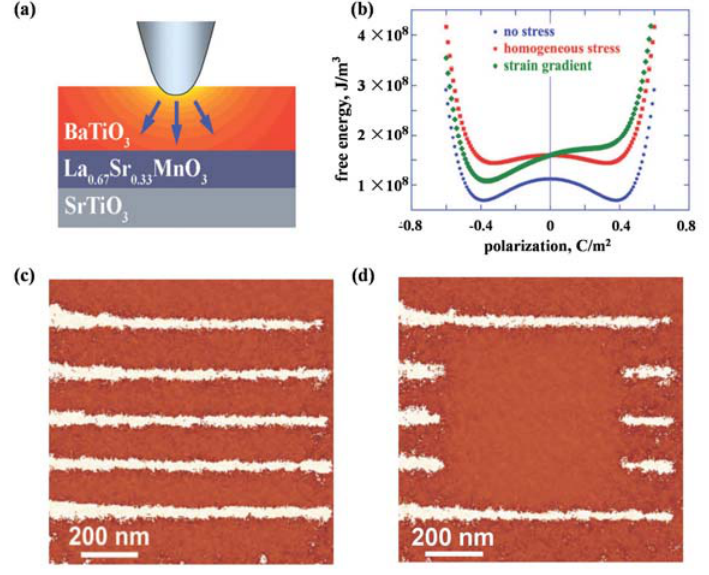
Figure 10. ( a ) Sketch of the strain gradient and associated flexoelectric field (arrows) induced by the AFM tip pushing on the surface of the BTO/LSMN heterostructure; ( b ) free-energy calculations for the epitaxially clamped BTO film without any tip pressure (blue curve), with homogeneous compressive stress of 3.2 GPa (red curve), and with the calculated flexoelectricity from the tip-induced strain gradient (green curve), where flexoelectricity skews the double well, forcing polarization switching toward the stable downward state; ( c ) domain lines mechanically written in the BTO film by scanning the film with a piezoresponse force microscopy (PFM) tip under a loading force of 1500 nN; ( d ) the same domain structure modified by electrical erasure of the mechanically written domains, which is performed by scanning the central segment with the tip under a dc − 3-V bias